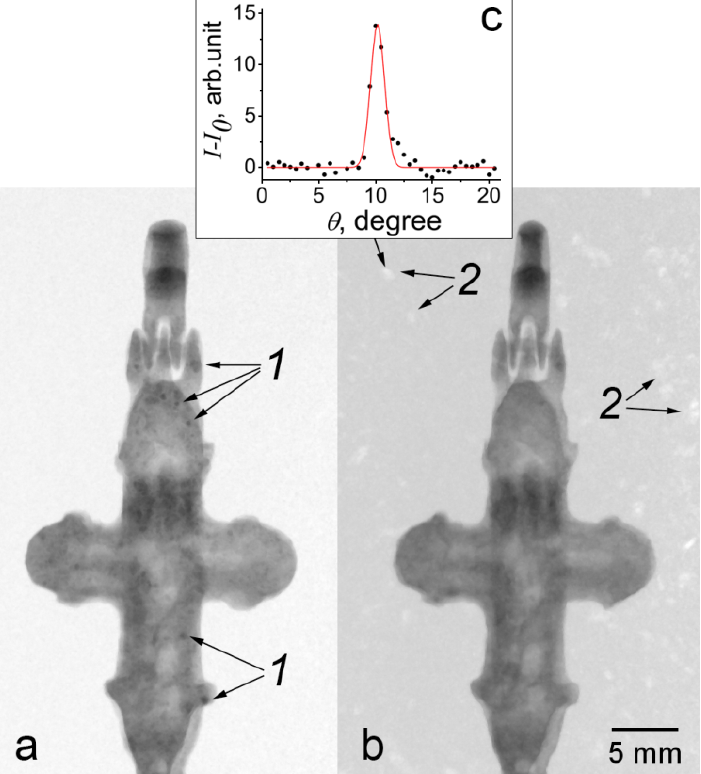
Figure 3. Images of the cross from Soroguzhino-2. Maps of the minimum ( a ) and maximum ( b ) intensity in the angular range of 20° near the frontal view of the cross: 1—images of grains, 2—reflections from grains; a rocking curve of one of the reflections is shown in ( c ).